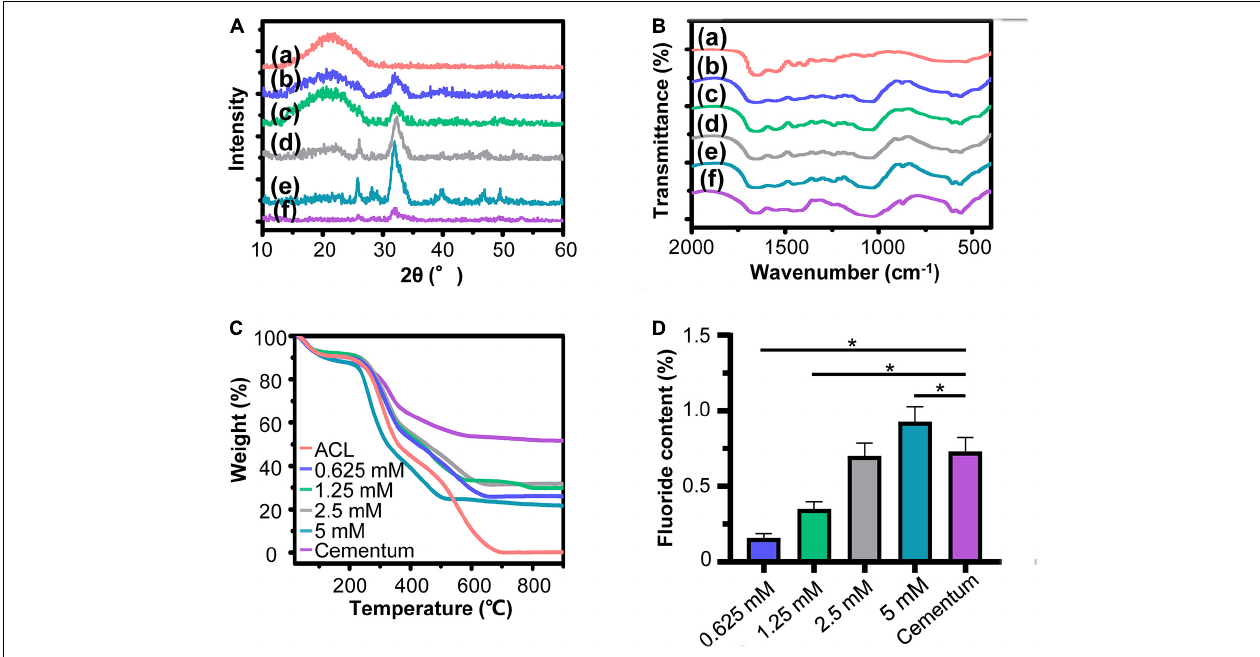
FIGURE 5 | Characterization of biomimetic cementum. (A) XRD spectra, (B) FITR spectra, (C) TGA result, and (D) fluorine content. In A, B , (a) ACL, (b–e) indicates 0.625, 1.25, 2.5, and 5 mM group of biomimetic cementum, respectively. (f) Cementum. Asterisk on top of each bar indicated statistically difference between groups ( p <